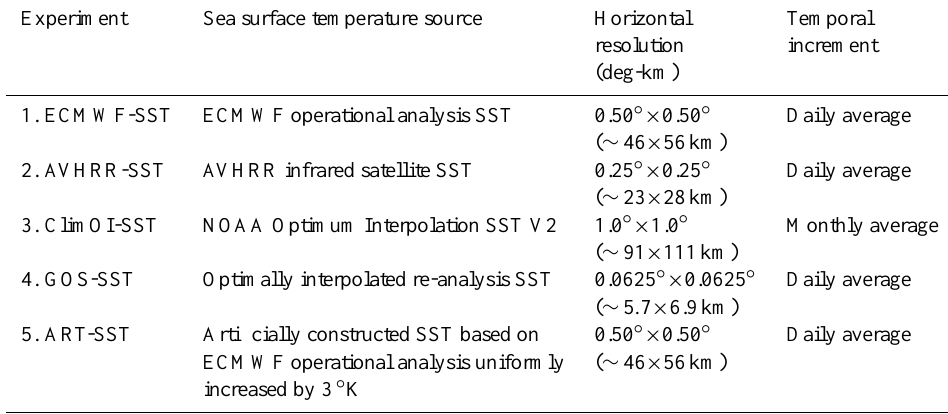
Fig. 3. Horizontal distribution of the sea surface temperature ( ◦ K) of 21 January 2004 at 00:00 UTC based on (a) ECMWF analysis, (b) AVHRR infrared satellite data, (c) NOAA 30-yr monthly climatology and (d) optimally interpolated GOS reanalysis. Table 1. The experiments and the characteristics of the sea surface temperature